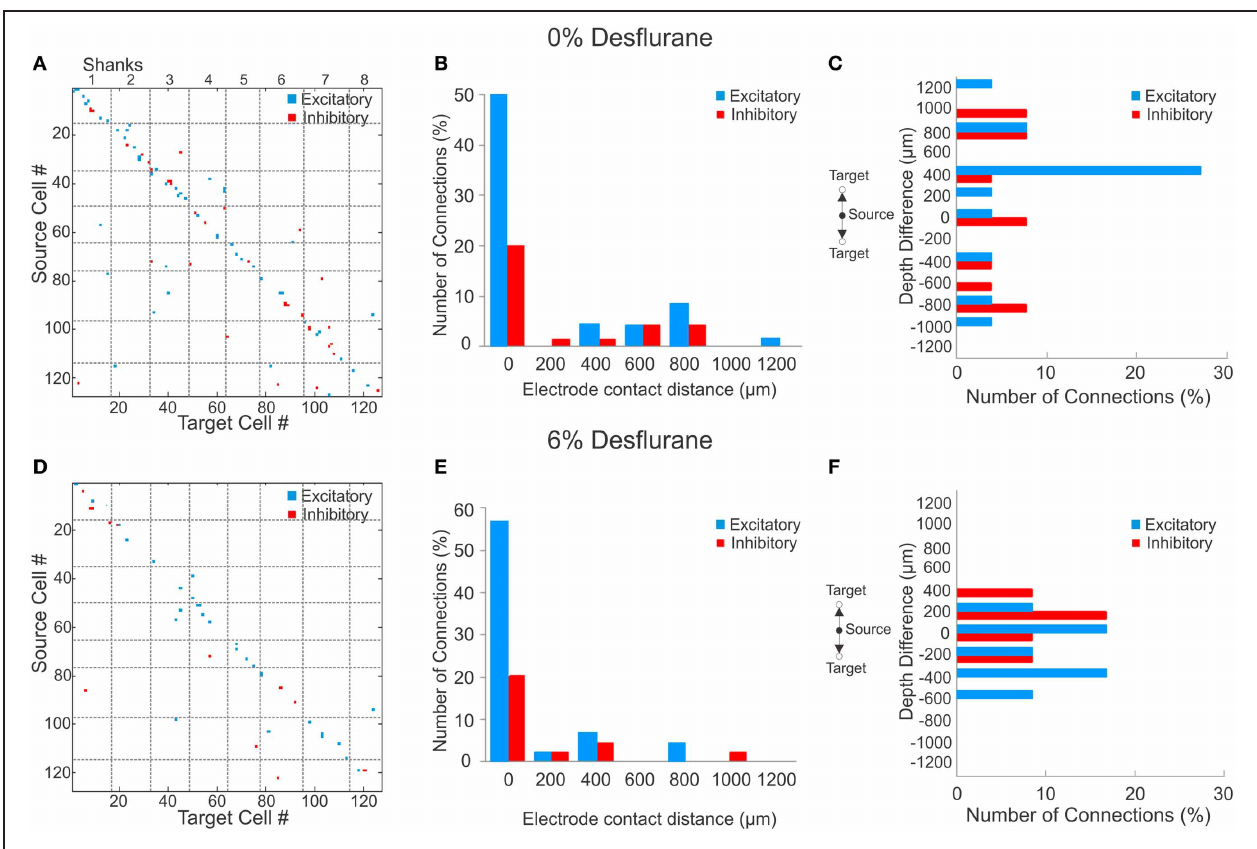
FIGURE 2 | Excitatory and inhibitory connections at wakefulness and under anesthesia. (A) Matrix of observed excitatory and inhibitory connections for all rats combined at wakefulness arranged by order of mapping. Cells were numbered from 1 to 127 based on their position of their electrode contact within the array, and arbitrarily within electrode contacts, with the result that consecutive numbers are mapped to neighboring cells. Points on the diagonal represent within-electrode connections, points near the diagonal represent within-shank connections, and points far off the diagonal represent between-shank connections. Most excitatory (blue) and inhibitory (red) connections are found along the diagonal representing connections within or near the same contact. (B) Distribution of distance between source and target units during wakefulness. The number of